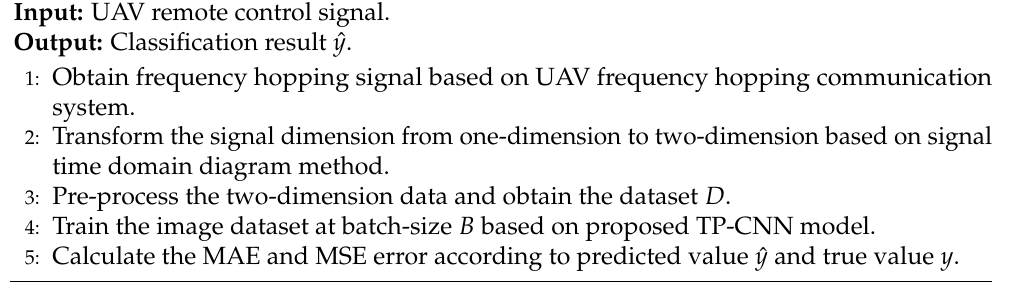
Figure 2. Two methods for feature fusion. Algorithm 1 Proposed SNR evaluation algorithm.